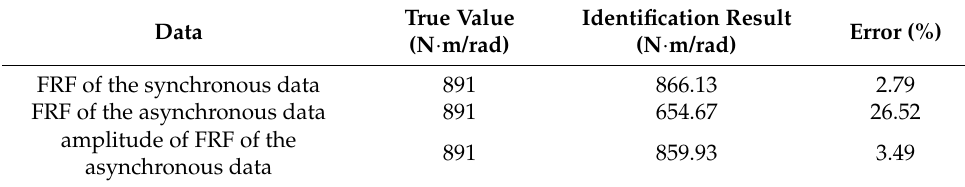
Table 1. Stiffness identification result of the synchronous and asynchronous data.